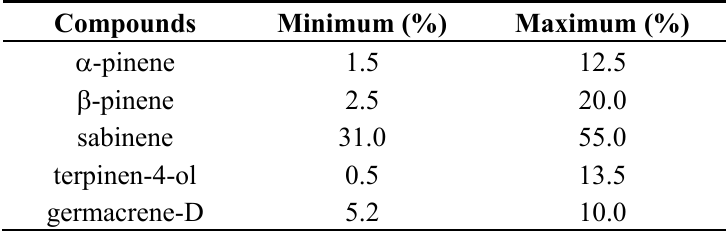
Table 2. Composition of the IRAM standard (Argentina).